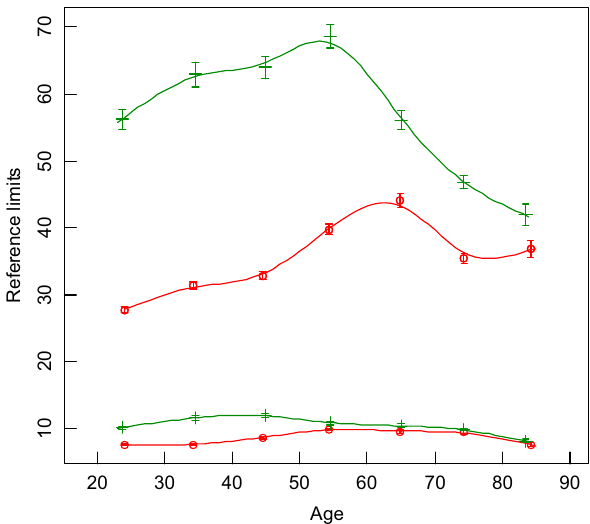
Figure 1: Age dependent reference limits of the catalytic activity concentrationof alanineaminotransferase(ALT,U/L) determinedwith the truncated minimum chi-square (TMC) method in a large data set (n=177,912) from outpatient provided by a university hospital. The RLs calculated in 10 years intervals are connected by a cubic smoothing spline, the lower line for lower RLs (2.5th percentile) and the upper line for upper RLs (97.5th percentile). The green symbols (crosses) and lines represent men, the red symbols (circles) and lines represent women with vertical 95% confidence limits (taken from ref.